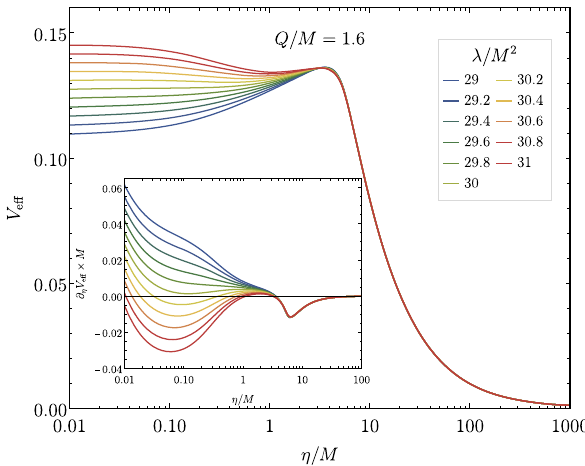
Fig. 40 Same as Fig. 39 for coupling (i) and for several values of the coupling constant λ . The extrema of V eff , and thus the zeros of ∂ η V eff (inset), correspond to light rings. Depending on the coupling constant λ there are 3, 5 or 7 light rings for symmetric